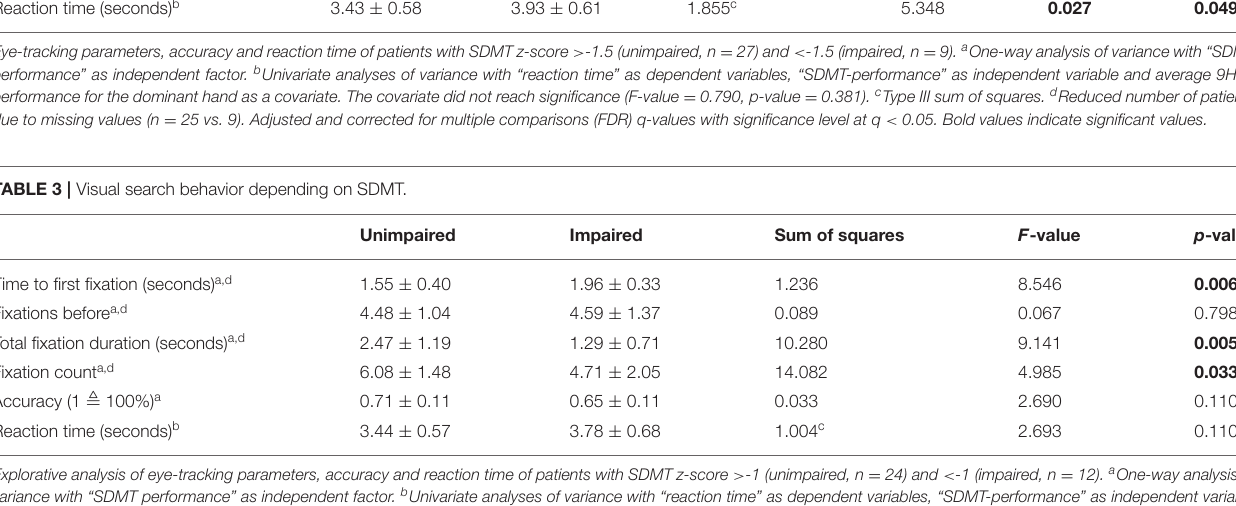
Figure 3 ) but not TFF unexpected ( r = − 0.212, p = 0.229), as well as between SDMT and TFD expected ( r =